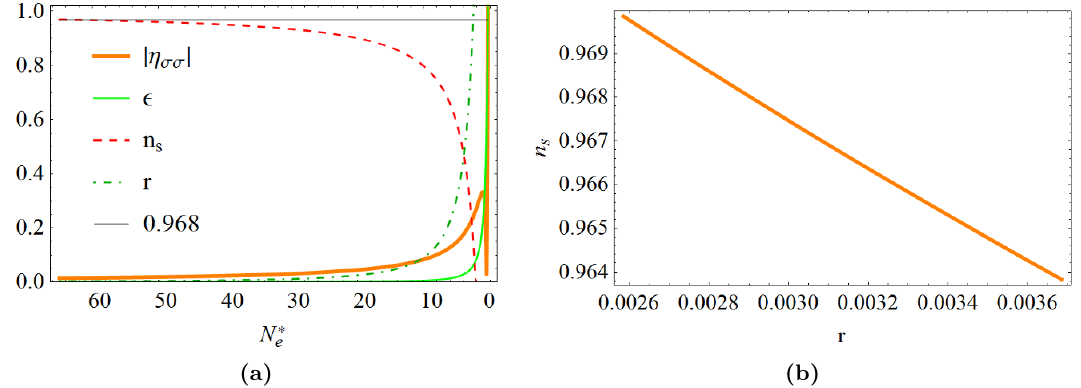
Figure 4. (a) Evolution of the slow-roll parameters (cid:15) (light green line), j (cid:17) (cid:27)(cid:27) j (dashed orange line), scalar-to-vector ratio r (green line) and spectral index n s (red line) as a number of e-foldings before the end of in(cid:13)ation N (cid:3) ; (b) ( n s , r ) contour at 55 (cid:20) N (cid:3) (cid:20) e e